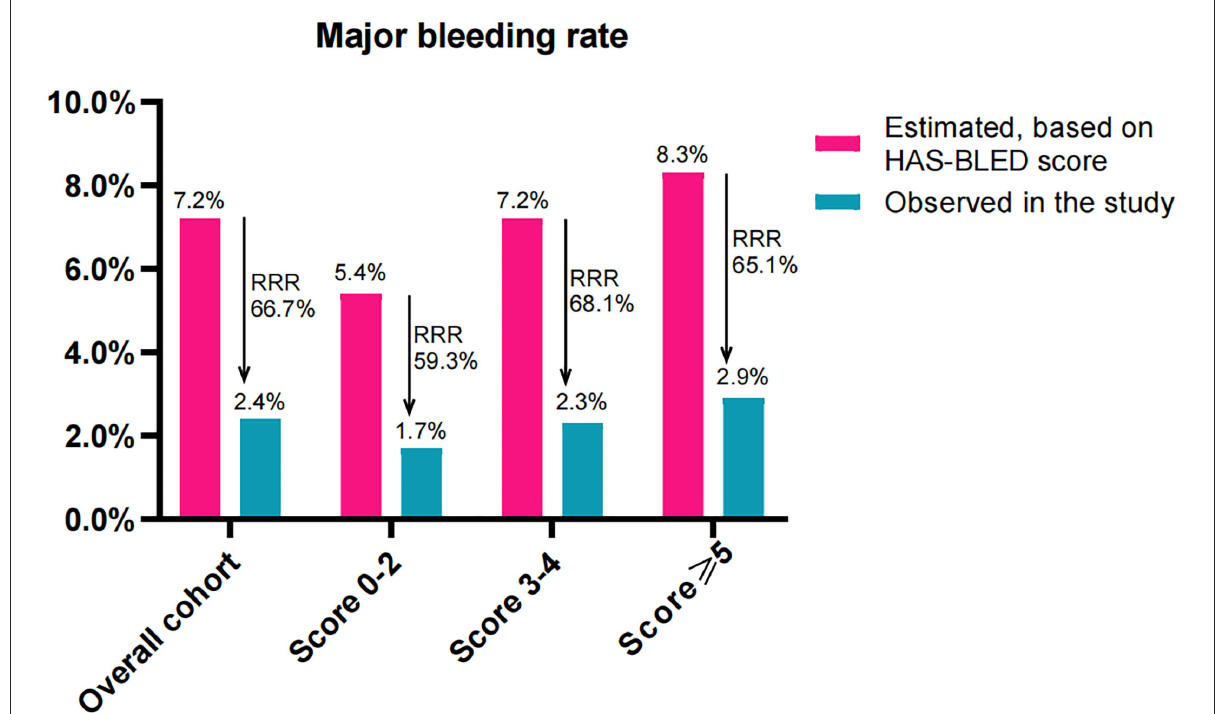
FIGURE5 Effectiveness of LAAC in risk reduction of major bleeding (100 patient-years) during the follow-up in the study groups divided according to CHA 2 DS 2 -VASc score. RRR, relative risk